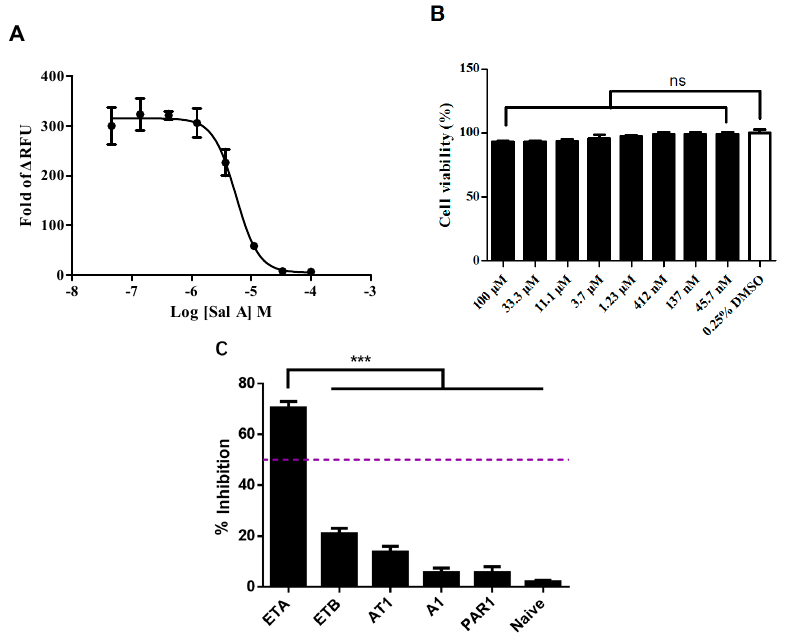
Figure 3. ET A R antagonist verification of Sal A. ( A ) Concentration-response curve in HEK293/ET A R cell line. The IC 50 value of Sal A was 5.7 µM (evoked by 20 nM ET-1); ( B ) Cytotoxicity evaluation of Sal A in HEK293/ET A R cells. The cell viability was determined after 30 min compound treatment by using ATP CellTiter-Glo kit; ( C ) Selectivity assay of Sal A in five recombinant HEK293 cell lines. Purple dot-line: 50% inhibition. Data were expressed as means ± SD of three independent experiments. Statistical analysis by using one-way ANOVA with Tukey test. ns: no significance,